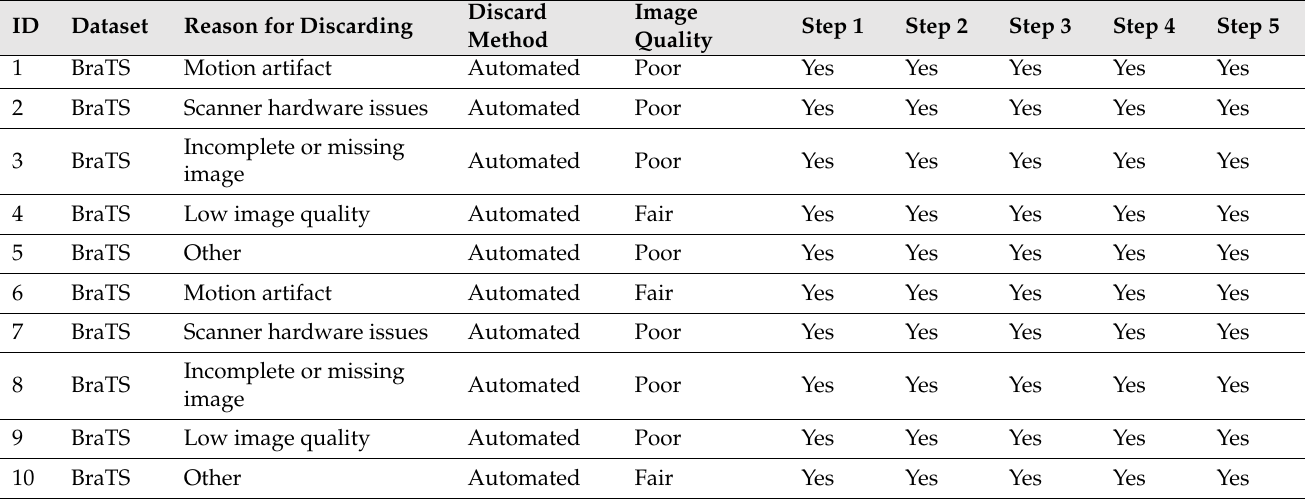
Table 3. Discarded images with reasons, discard method, and image quality ratings during